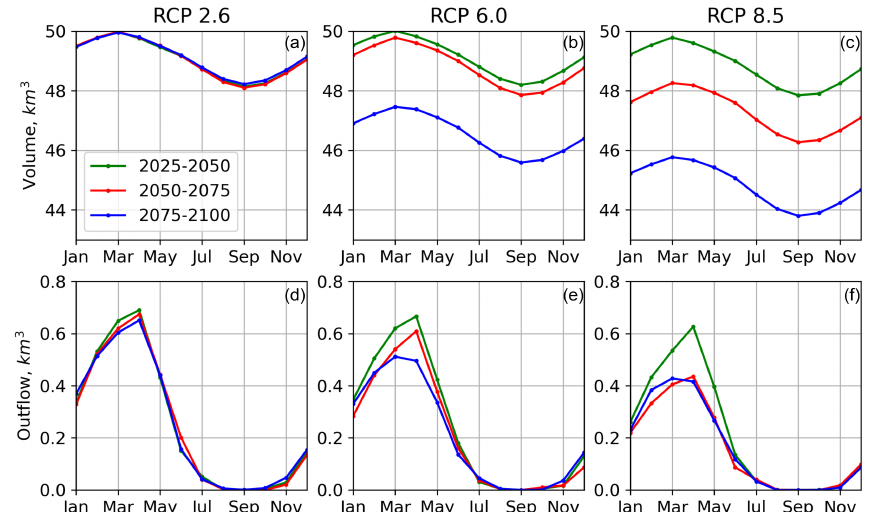
Figure 7. Inter-annual variations of the Small Aral Sea water volume ( a – c ) and the dam outflow ( d – f ) with increased lake surface (48.5 m.a.s.l.) depending on the RCP scenarios averaged for the periods of second, third and fourth quarters of the 21st